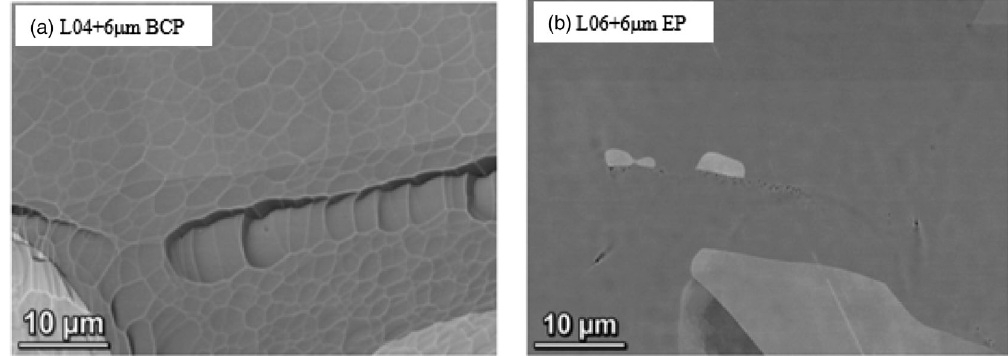
FIG. 3. Higher magnification SE mode SEM images of the coupon surfaces after about ∼ 6 μ m surface removal of (a) sample L04 with BCP and (b) sample L06 with EP.